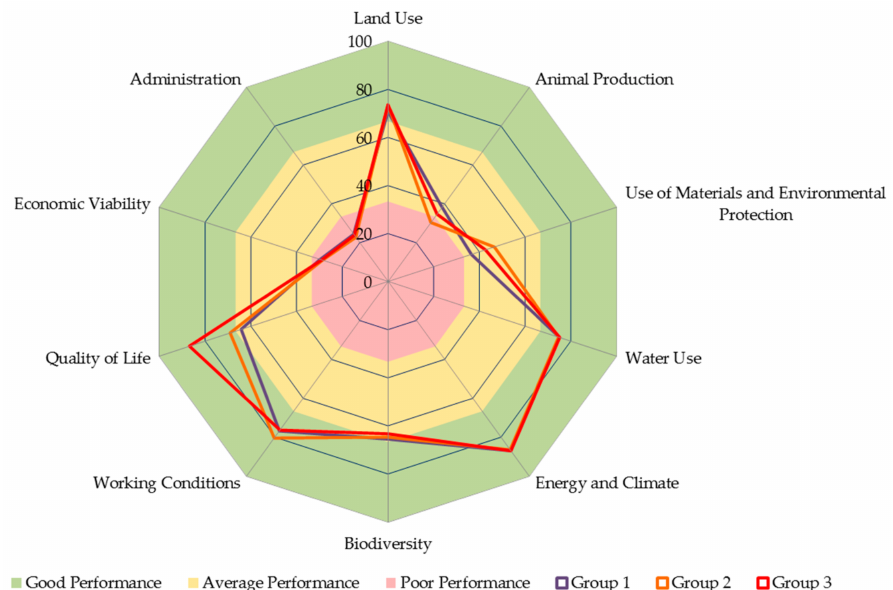
Figure 5. Degree of sustainability of the Kichwa indigenous communities for groups 1, 2, and 3 of sector A in the north of the Yasun í Biosphere Reserve in the Ecuadorian Amazon region.